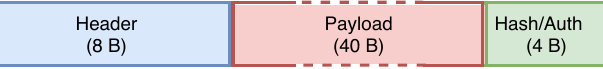
Figure 9. Transmitted frame